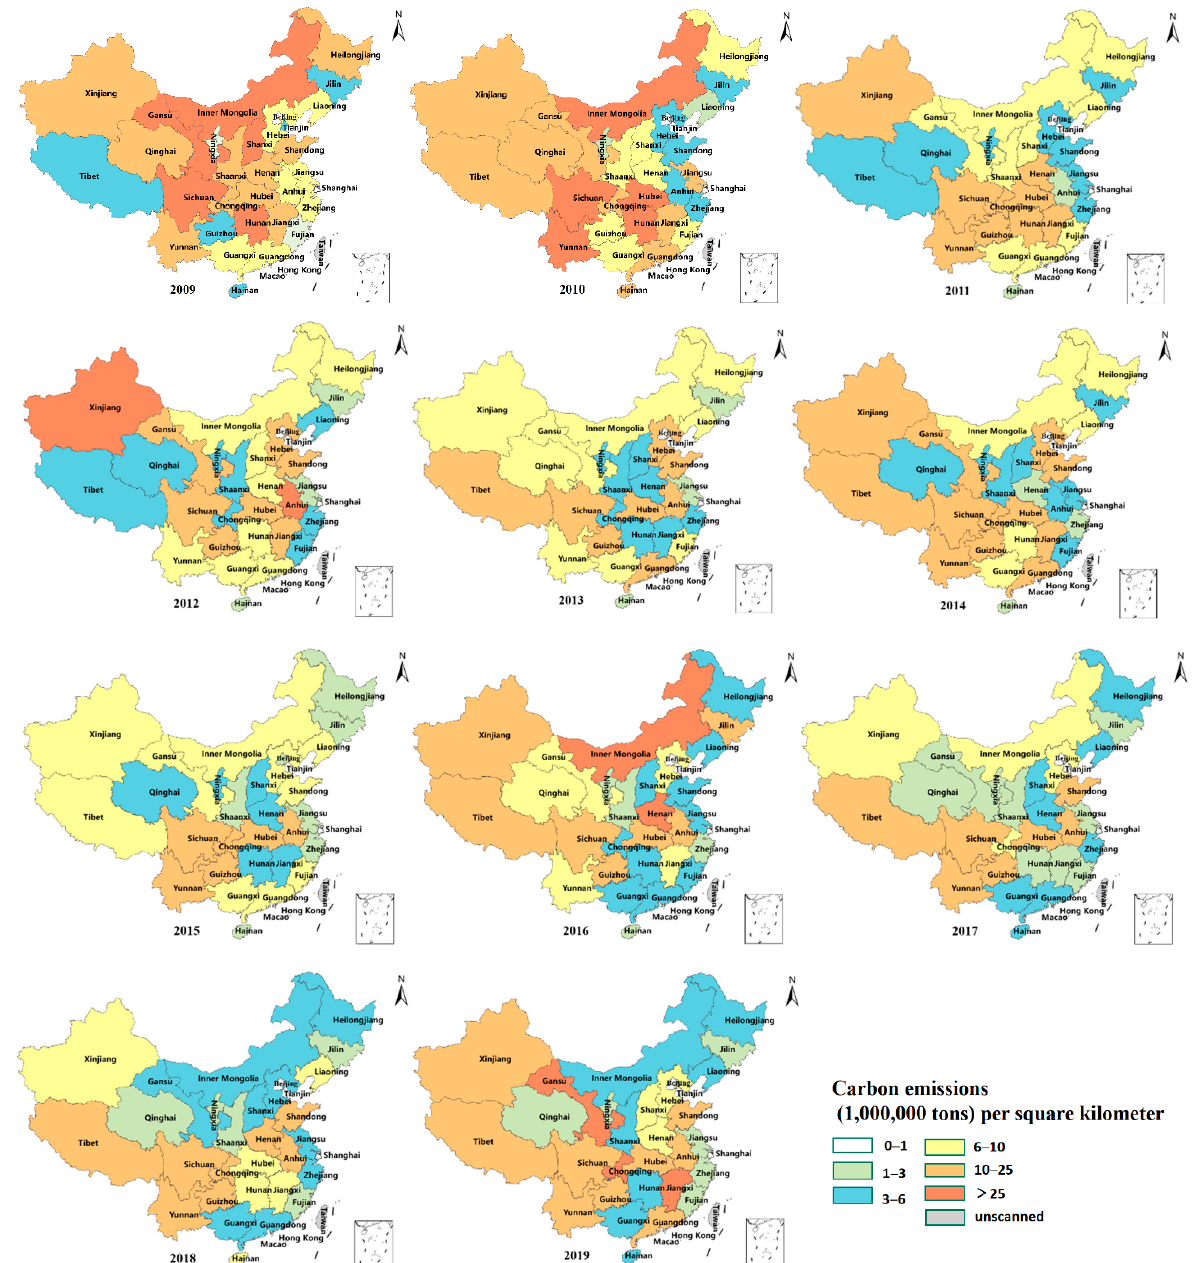
Figure 7. Regional differences in GHG emissions from road construction during 2009–2019. It is also indicated in Figure 7 that GHG emissions from road construction are shifting from east to west regions. When the years 2009 and 2019 are compared, almost all of the eastern regions on the map have changed from yellow to green in 2019, while many provinces in the western region have turned orange, indicating a significant decrease of GHG emissions in eastern regions and increase in western regions. Transportation infras- tructure is widely regarded as a valuable tool for a region’s economic development [35]. Since the reform and opening up policy was implemented in 1978, the eastern regions have experienced rapid economic growth, and there is a polarization between eastern coastal and inland regions [36]. Later policy centered on western region development resulted in a large amount of transportation infrastructure construction in western regions. As a result, the center of GHG emissions from roads shifted from the east to the